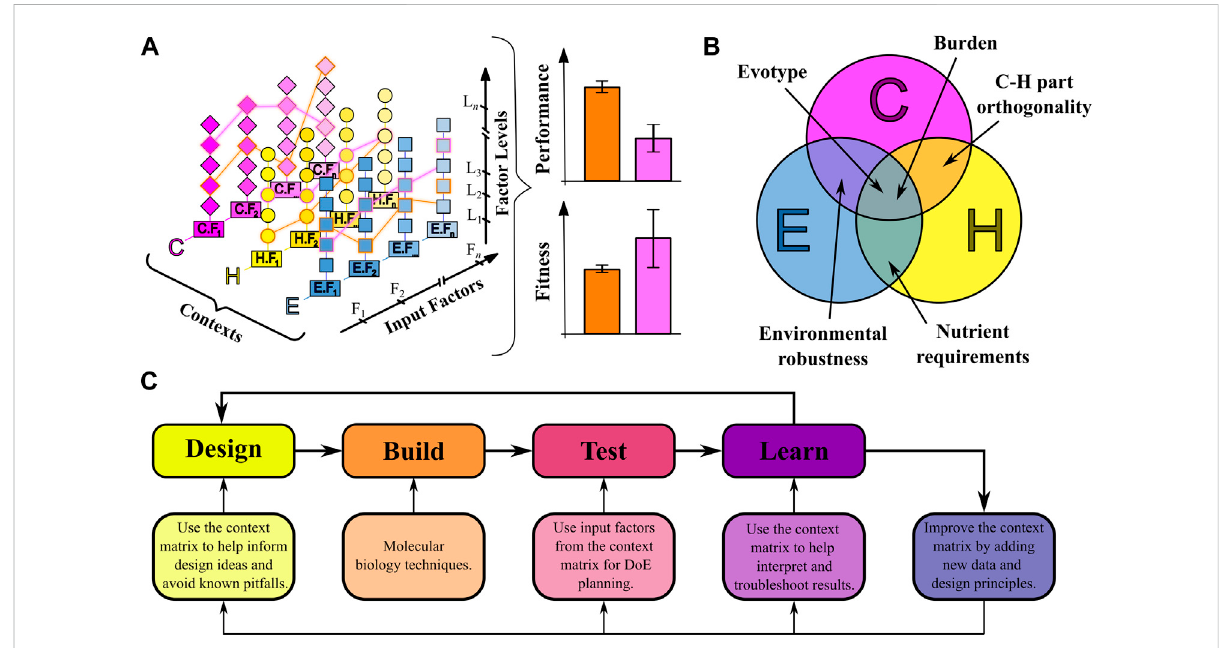
FIGURE 2 The context matrix and its applications. (A) A representation of the context matrix. The three primary contexts (construct = C, host = H, environment = E), are each composed of a number of input factors (C.F 1 , E.F 2 , ... ), which are described in Figure 1. The input factors are further subdividedintolevels(C.F 1 .L 1 ,C.F 1 .L 2 , ... ).Continuousinputfactors(suchastemperatureorglucoseconcentration)cantakeanyfeasible fi nitelevel, whereas categorical input factors (such as species or gene orientation) are restricted to discrete values. The chosen combination of all